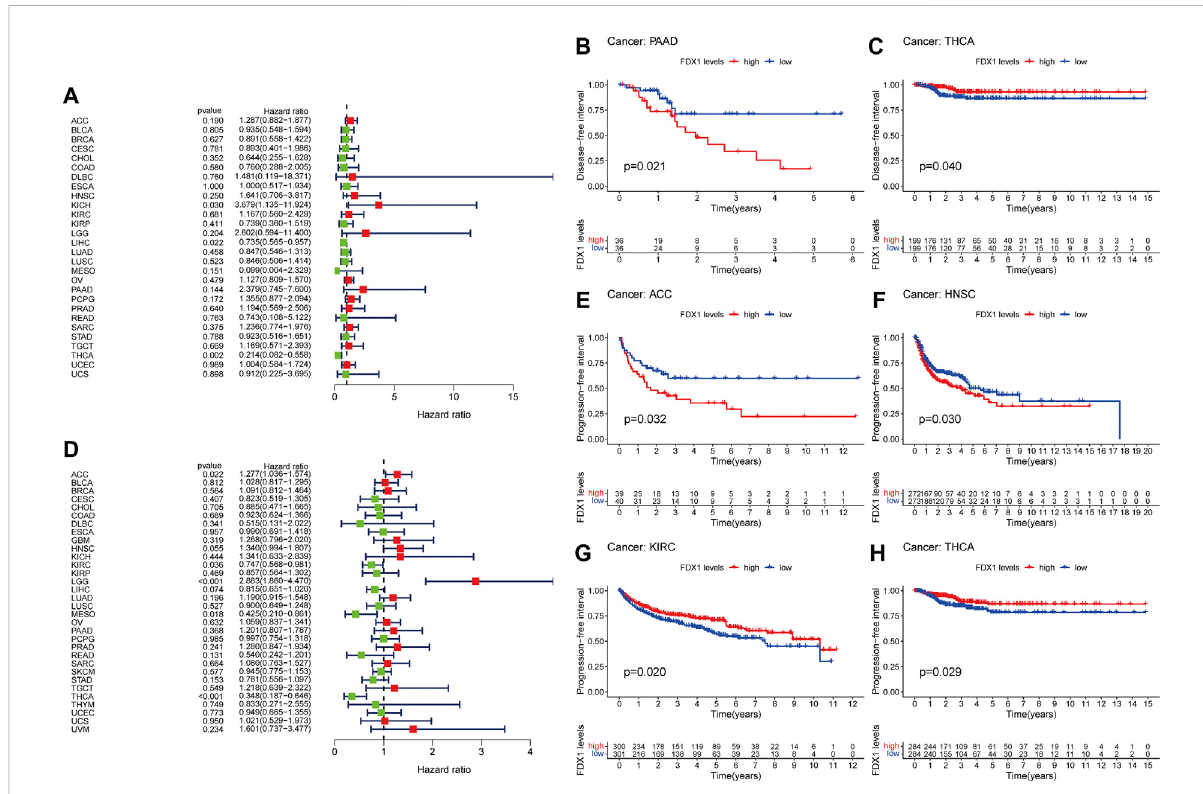
FIGURE 3 Prognostic assessment of FDX1 expression in DFI and PFI. Correlation between FDX1 expression and DFI (A) and PFI (D) by utilizing Cox proportional hazards model (B,C) Kaplan-Meier analysis of DFI in patients with high and low FDX1 expression (E – H) Kaplan-Meier analysis of PFI in patientswithhighandlowFDX1expression.HR(hazardratio) > 1indicatesthatFDX1maybeanadversefactorintheoccurrenceanddevelopmentof cancer, and it is shown in red; 0 < HR < 1 indicates that FDX1 may be a protective factor in cancer, and it is shown in